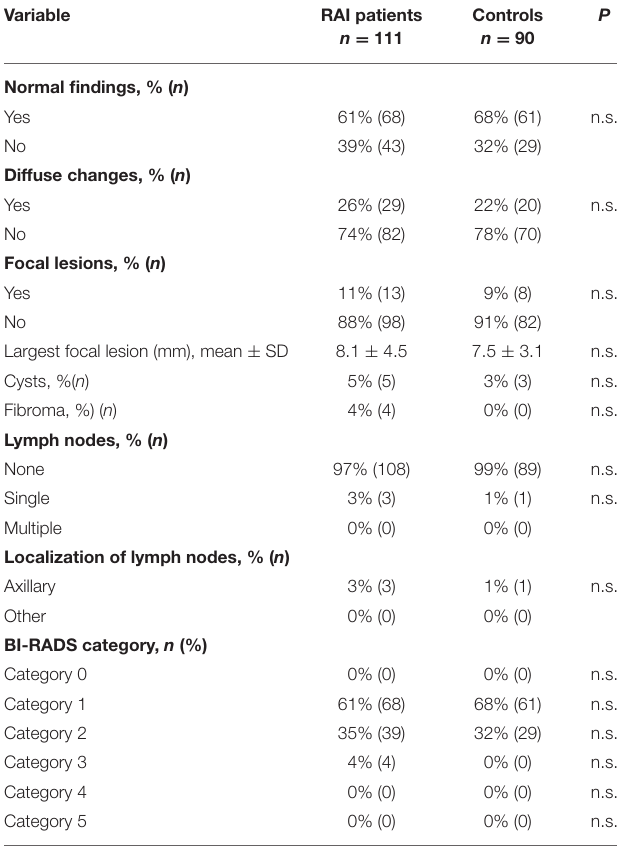
TABLE 3 | Breast ultrasonography